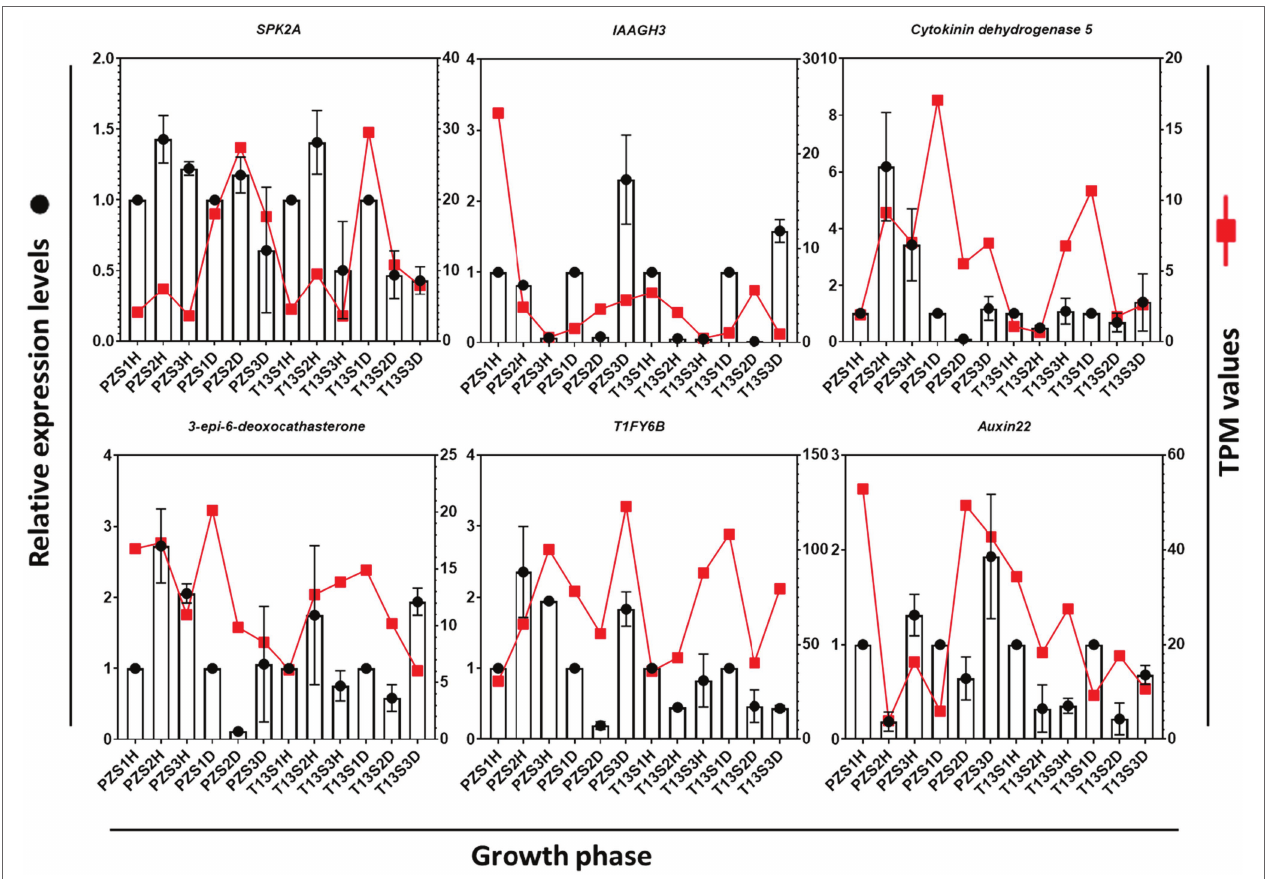
FIGURE 5 | Comparison of the expression levels of six selected DEGs with transcripts per million (TPM) values. Quantitative real-time PCR (qRT–PCR) values represent the column chart ( y -axis on the left), and transcriptome values are shown as red lines ( y -axis on the right). The x -axis represents three growth phases in healthy and diseased “PZ” and